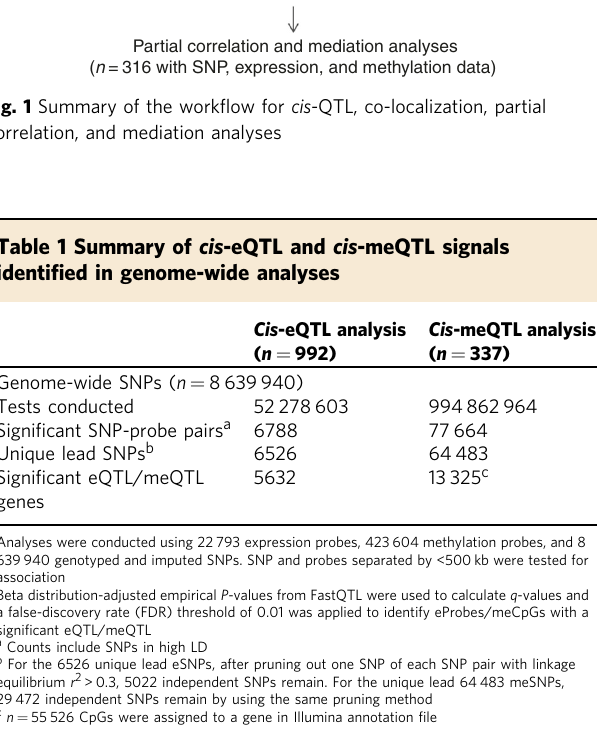
Table 1. At an false-discovery rate (FDR) of 0.01, we detected a cis -eQTL for 6788 expression probes, corresponding to 5632 genes (i.e., cis -eGenes), 6526 unique lead eSNPs, and 5022 independent eSNPs (after linkage disequilibrium (LD) pruning).